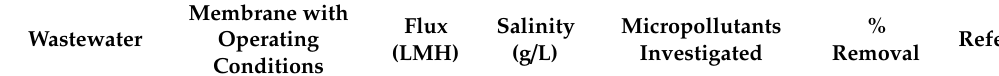
Table 4. Removal of OMPs in OMBR and major operating